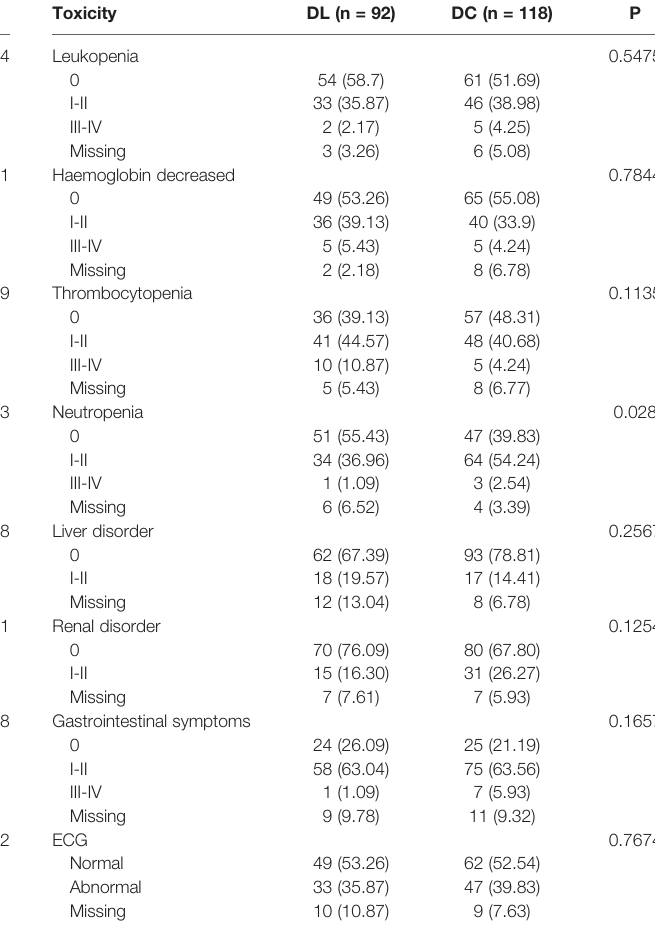
TABLE 5 | Subgroup analysis of side effects of 3 – 4 cycles of adjuvant therapy (DL versus